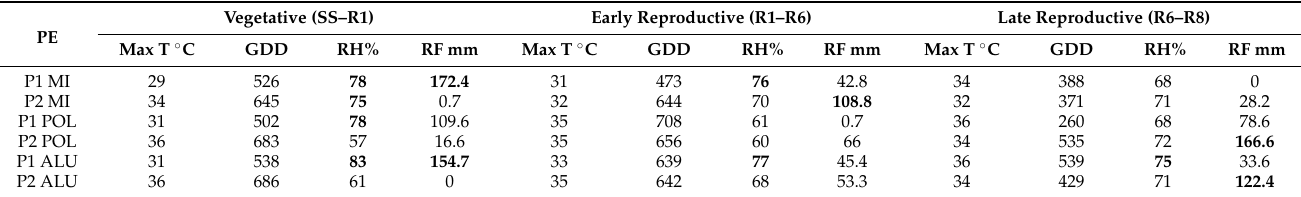
Table 1. Maximum temperature ( ◦ C), growing degree days (GDD), average relative humidity (RH%) and cumulative rainfall (mm) during vegetative (SS–R1), early reproductive (R1–R6) and late reproductive (R6–R8) at six production environments. Vegetative (SS–R1) Early Reproductive (R1–R6) PE